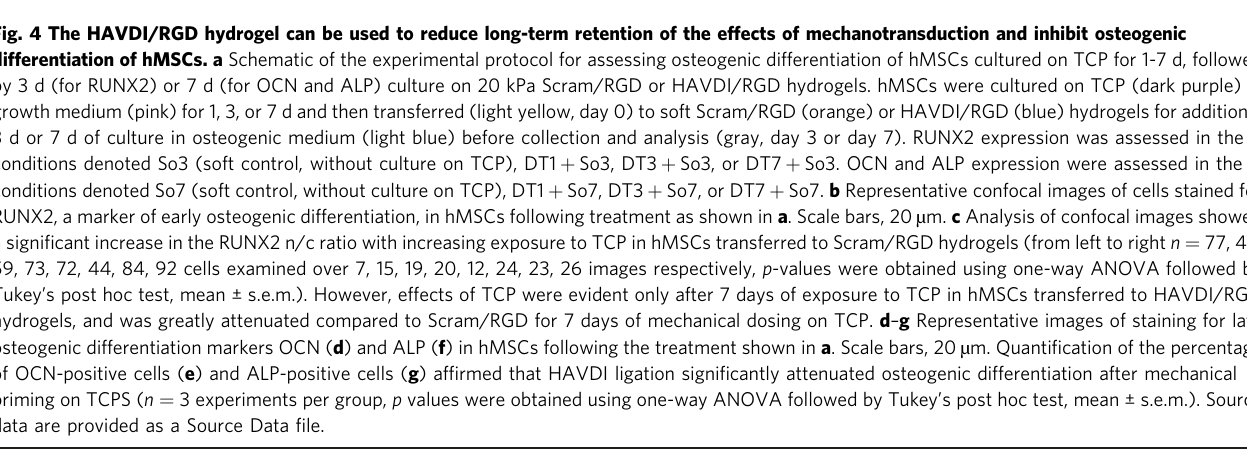
Fig. 4 The HAVDI/RGD hydrogel can be used to reduce long-term retention of the effects of mechanotransduction and inhibit osteogenic differentiation of hMSCs. a Schematic of the experimental protocol for assessing osteogenic differentiation of hMSCs cultured on TCP for 1-7 d, followed by 3 d (for RUNX2) or 7 d (for OCN and ALP) culture on 20 kPa Scram/RGD or HAVDI/RGD hydrogels. hMSCs were cultured on TCP (dark purple) in growth medium (pink) for 1, 3, or 7 d and then transferred (light yellow, day 0) to soft Scram/RGD (orange) or HAVDI/RGD (blue) hydrogels for additional 3 d or 7 d of culture in osteogenic medium (light blue) before collection and analysis (gray, day 3 or day 7). RUNX2 expression was assessed in the conditions denoted So3 (soft control, without culture on TCP), DT1 + So3, DT3 + So3, or DT7 + So3. OCN and ALP expression were assessed in the conditions denoted So7 (soft control, without culture on TCP), DT1 + So7, DT3 + So7, or DT7 + So7. b Representative confocal images of cells stained for RUNX2, a marker of early osteogenic differentiation, in hMSCs following treatment as shown in a . Scale bars, 20 µ m. c Analysis of confocal images showed a signi fi cant increase in the RUNX2 n/c ratio with increasing exposure to TCP in hMSCs transferred to Scram/RGD hydrogels (from left to right n = 77, 49, 59, 73, 72, 44, 84, 92 cells examined over 7, 15, 19, 20, 12, 24, 23, 26 images respectively, p -values were obtained using one-way ANOVA followed by Tukey ’ s post hoc test, mean ± s.e.m.). However, effects of TCP were evident only after 7 days of exposure to TCP in hMSCs transferred to HAVDI/RGD hydrogels, and was greatly attenuated compared to Scram/RGD for 7 days of mechanical dosing on TCP. d – g Representative images of staining for late osteogenic differentiation markers OCN ( d ) and ALP ( f ) in hMSCs following the treatment shown in a . Scale bars, 20 µ m. Quanti fi cation of the percentage of OCN-positive cells ( e ) and ALP-positive cells ( g ) af fi rmed that HAVDI ligation signi fi cantly attenuated osteogenic differentiation after mechanical priming on TCPS ( n = 3 experiments per group, p values were obtained using one-way ANOVA followed by Tukey ’ s post hoc test, mean ± s.e.m.). Source data are provided as a Source Data